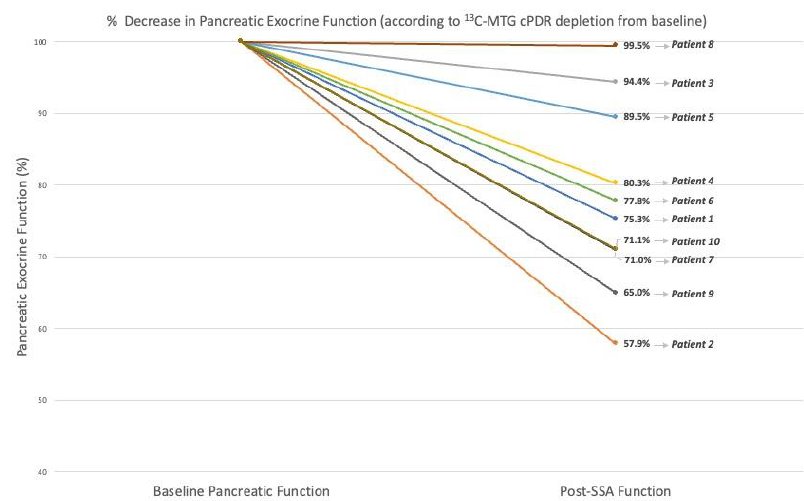
Figure 1. Composite line graph to show change of %cPDR of 13 C-MTG for each patient. Table 2. Before and after SSA functional exocrine